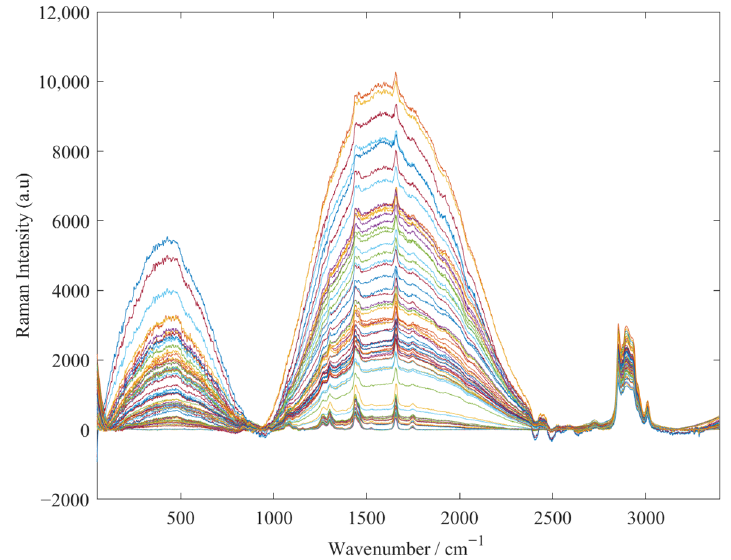
Figure 2. Raw Raman spectra of all peanut oil